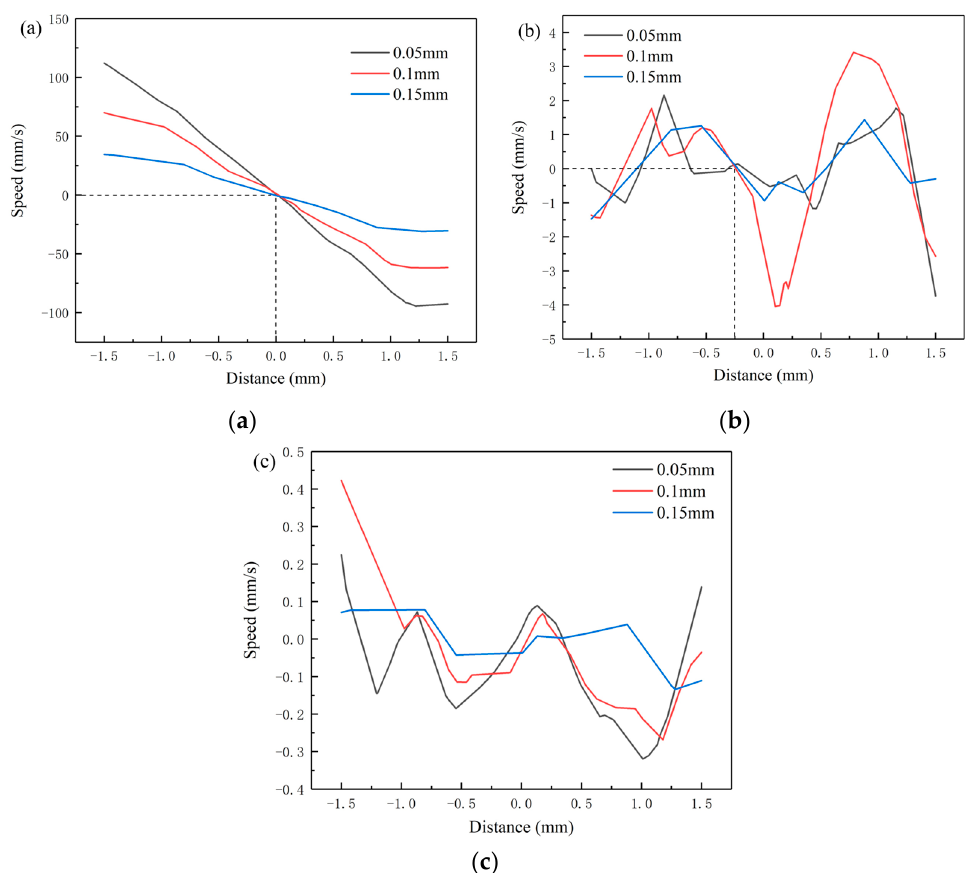
Figure 6. Speed curves of different distances from the bottom of the pin (1000 rpm, 120 mm/min, 5.8 mm pin length). ( a ) Velocity in the x-direction; ( b ) velocity in the y-direction; ( c ) velocity in the z-direction.